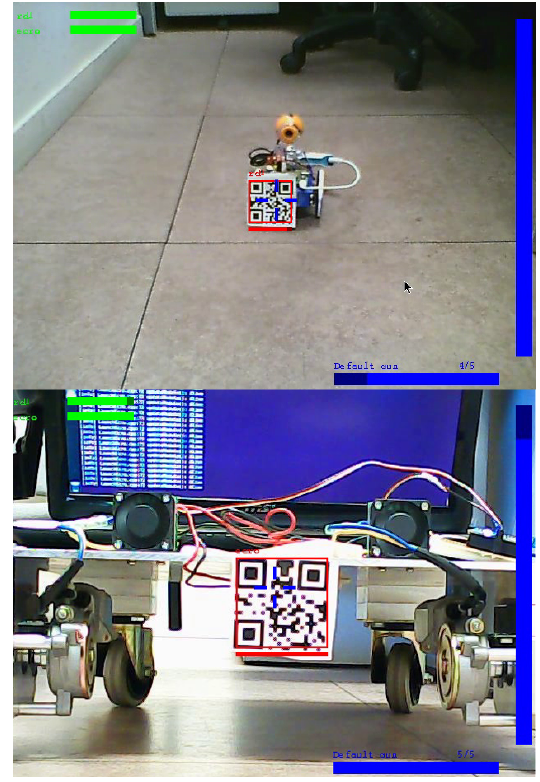
Fig. 4. Screenshots of Robot Devastation gameplay. The resolution of the images the players see is directly given by the robot webcam